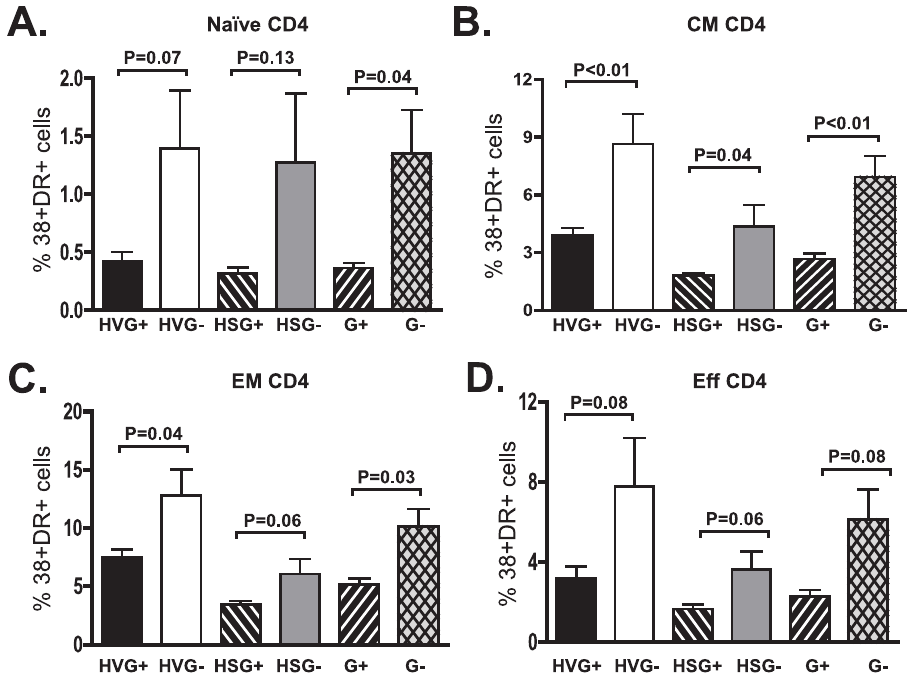
Figure 2. GBV-C is associated with reduced activation in CD4 + T cell subsets in treated and untreated HIV-infected individuals. The percentage of naive (A), central memory (CM; B), effector memory (EM; C) and effector (Eff; D) CD4 + T cells expressing CD38 and HLA-DR differed between GBV-C viremic (G + ) subjects and those without GBV-C viremia (G-). Results of subjects not receiving combination antiretroviral therapy (HIV viremic positive; HV) or those with suppressed HIV RNA on therapy (HS) and statistical evaluation are provided.